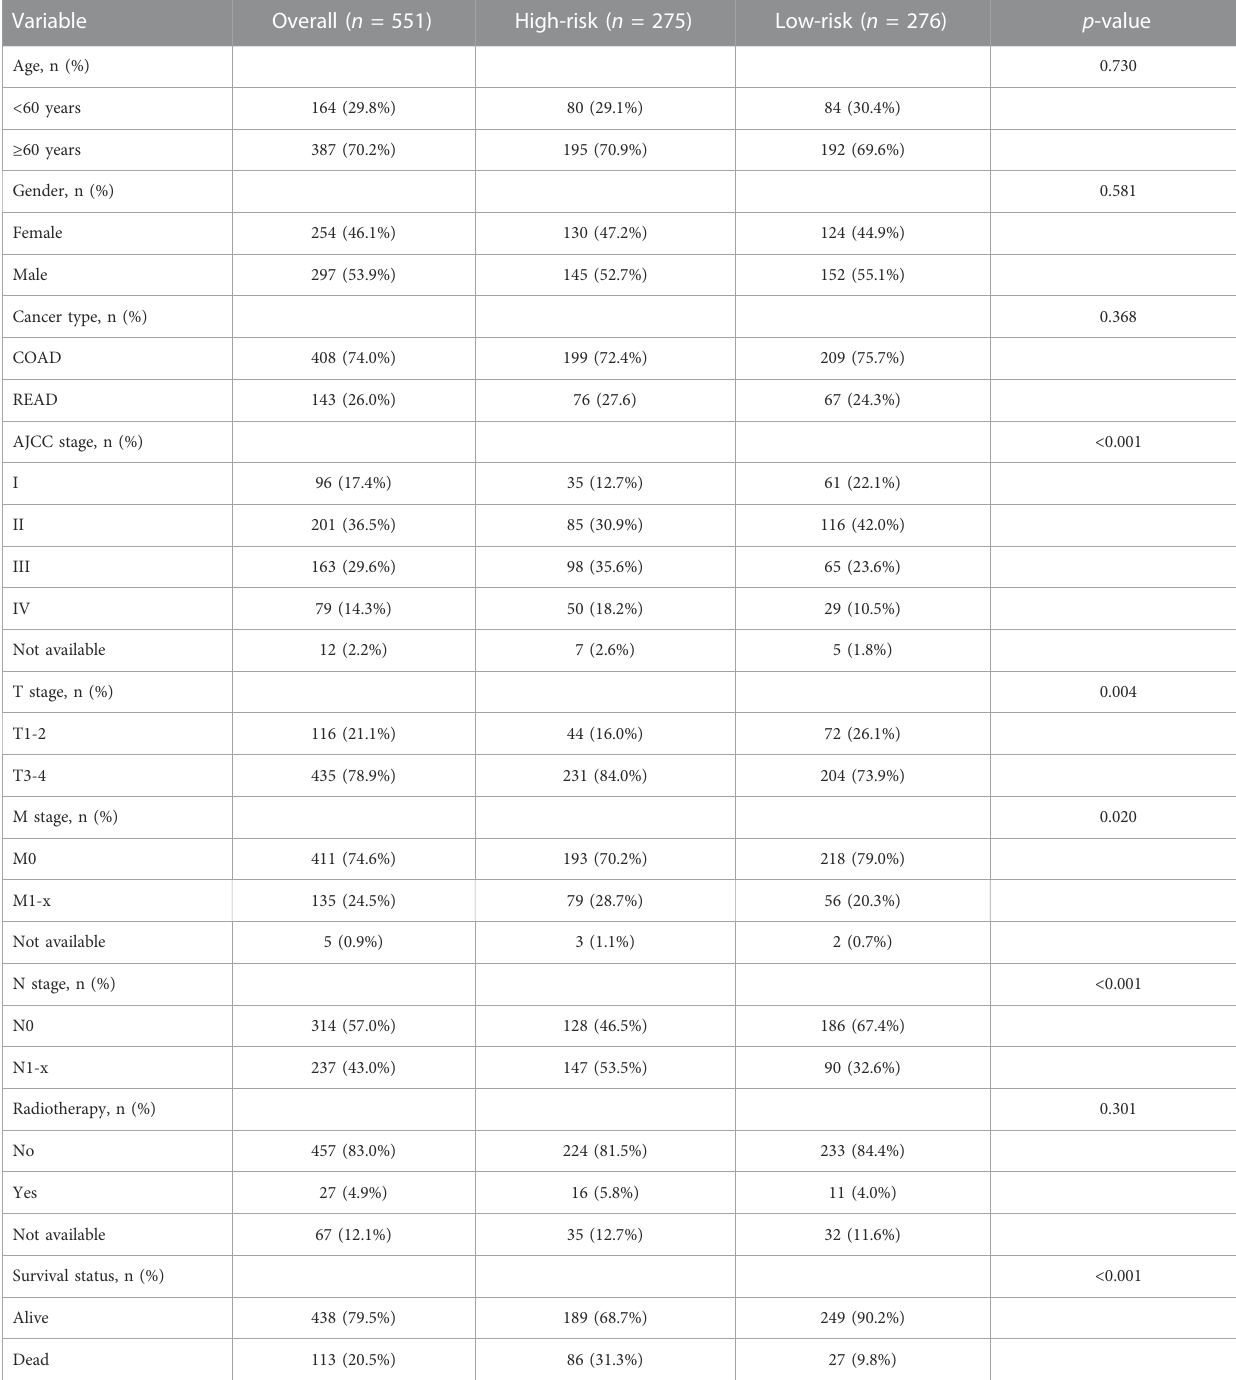
TABLE 1 Correlation between subgroups and clinicopathological factors in the TCGA cohort.